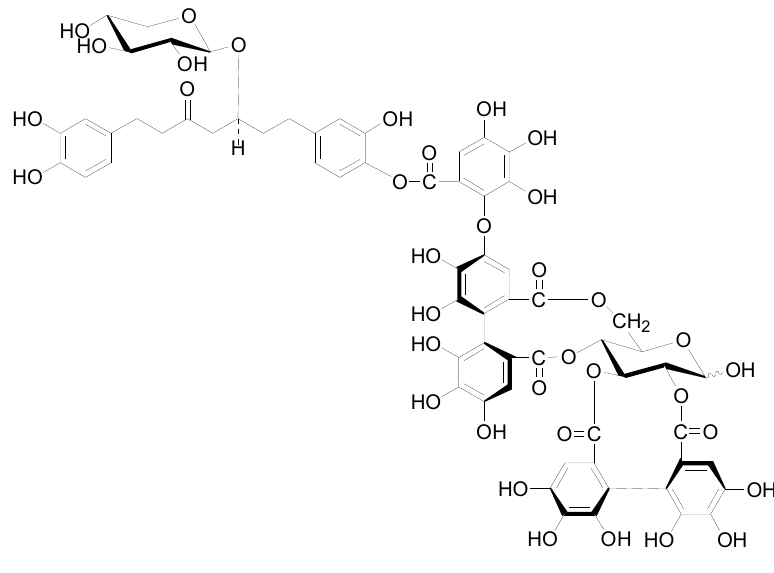
Figure 6. Structures of compounds 120 . Table 5. Structures of compounds 121 – 123 .